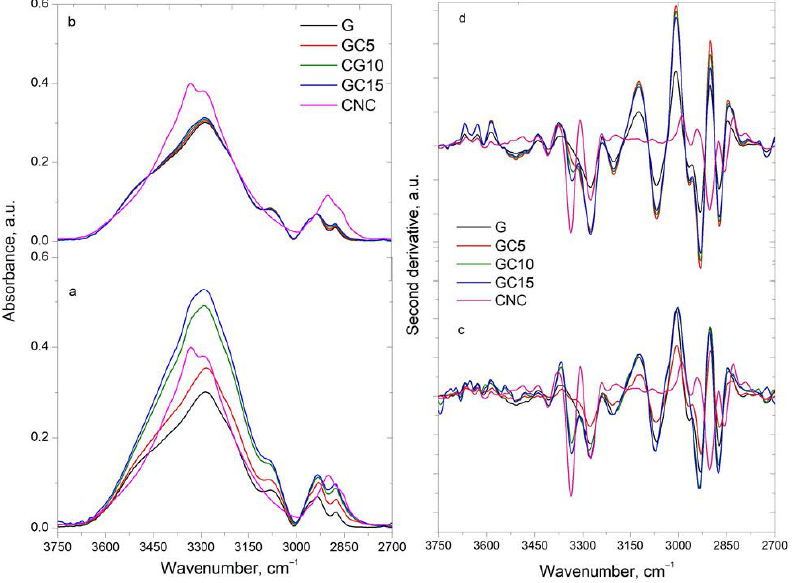
Figure 1. Experimental and calculated FTIR spectra ( a , b ) and their derivatives ( c , d ) in the 3750–2700 cm − 1 region.